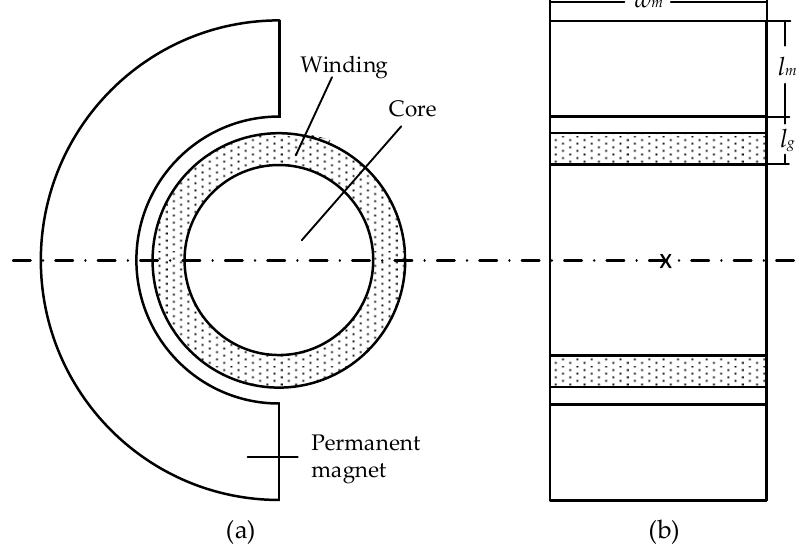
Figure 7. Permanent magnet and air gap. ( a ) front view; ( b ) side view.